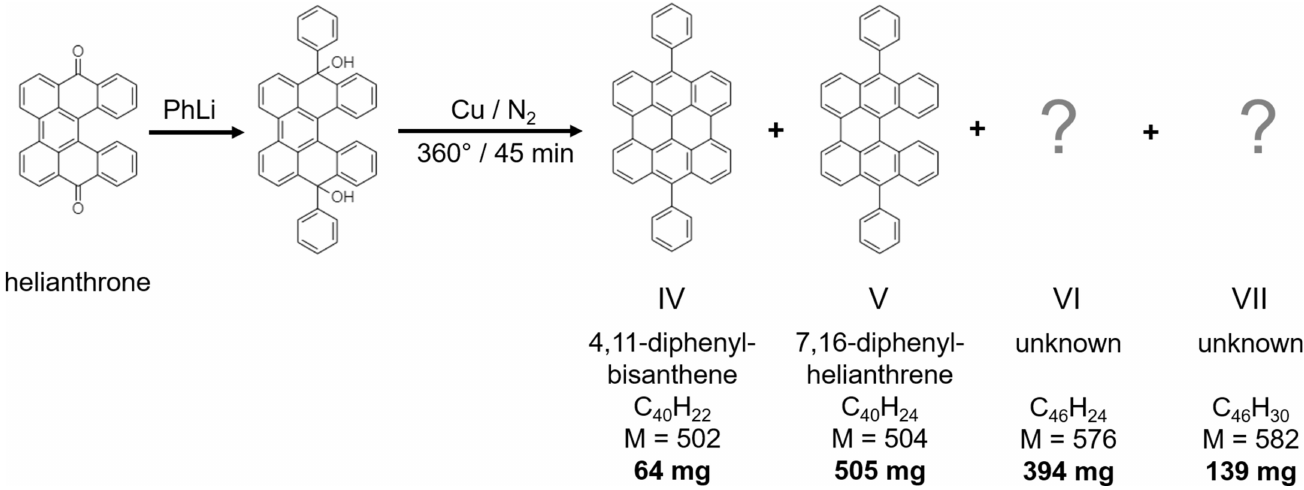
Figure 2 A stepwise model of the synthesis of 4,11-diphenylbisanthene (IV). The by-product V was identified and determined in Arabei & Pavich (2004). The molecular conformation and crystal structure of by-products VI and VII were unknown prior to their determination by the 3D ED method. For each product of the reaction, the formula, molecular weight ( M ) and yield (in bold) are